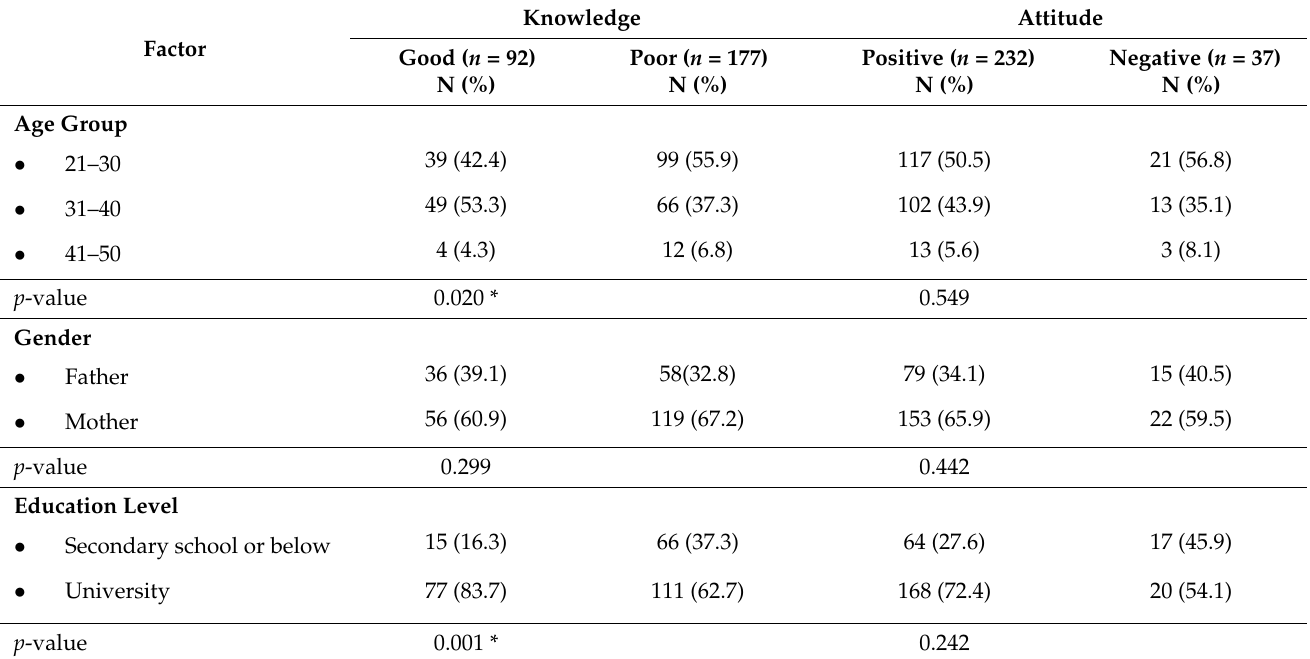
Table 3. Association between knowledge, attitudes, and socio-demographic characteristics of parents.